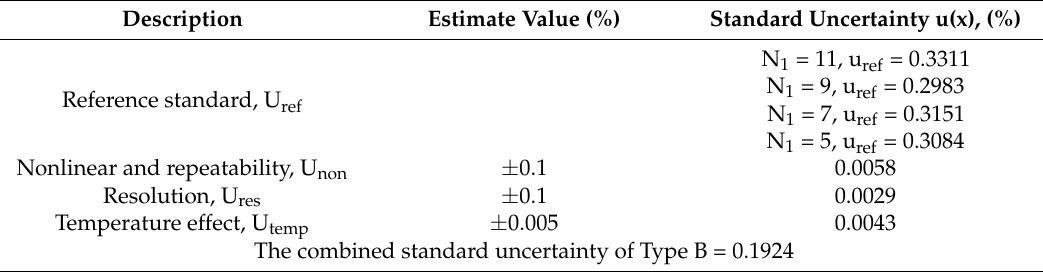
Table 11. The Type B uncertainty analysis for capacitive humidity